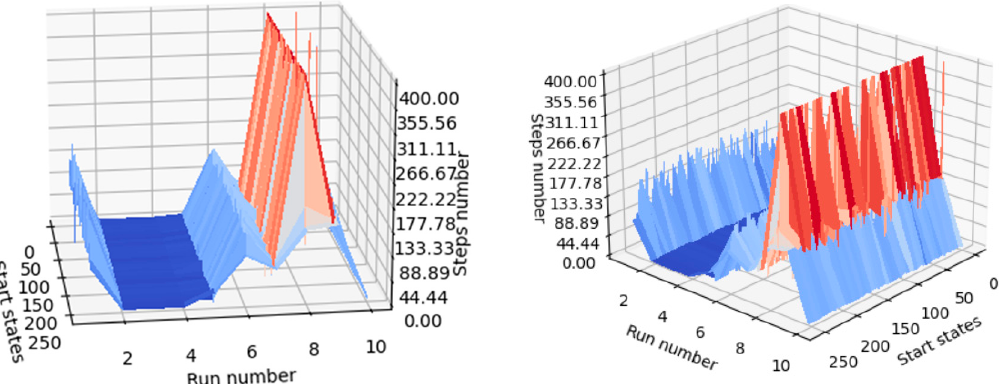
Figure 13. Visual indicator of agent performance (same graph observed from two